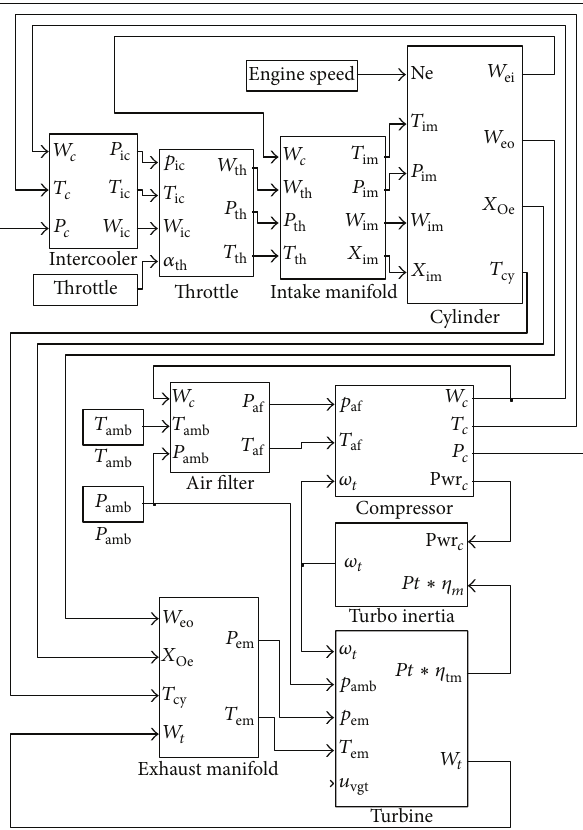
Figure 17: Complete control-oriented model.